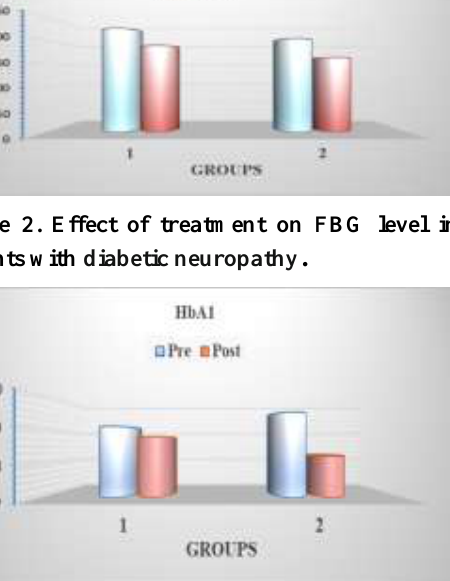
Figure 3.Effect of treatment on HbA 1c level in patients with diabetic neuropathy .